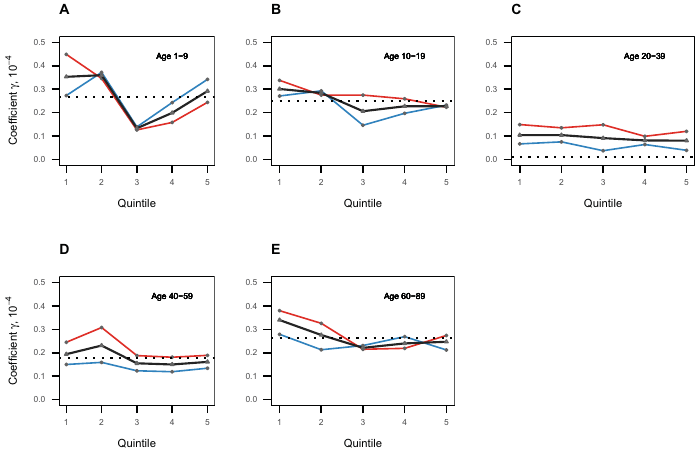
Fig 5. The regression estimates of the seven-day PM 10 concentration by quintile, separately by age group and gender. For each age group, the coefficients of the seven-day PM 10 concentration are estimated for all people (black line), and separately by gender (blue line for male and red line for female). The dotted horizontal lines denote the mean of the estimated coefficients based on all genders over quintiles.